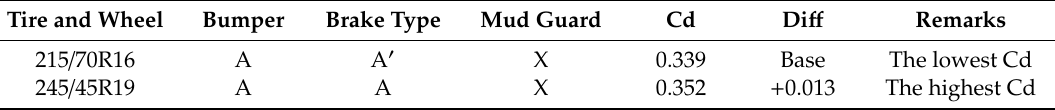
Table 4. Coefficients of drag for each tire type and option .